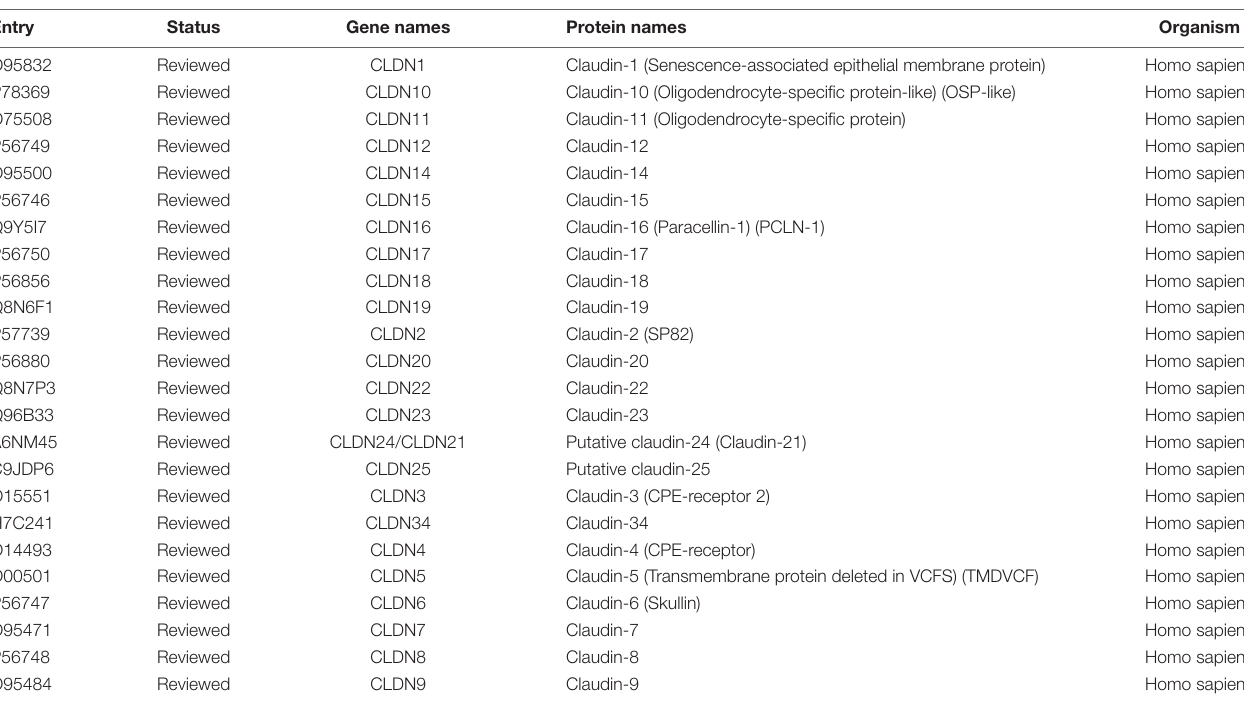
TABLE 1 | Twenty-four reviewed proteins of claudin family from the